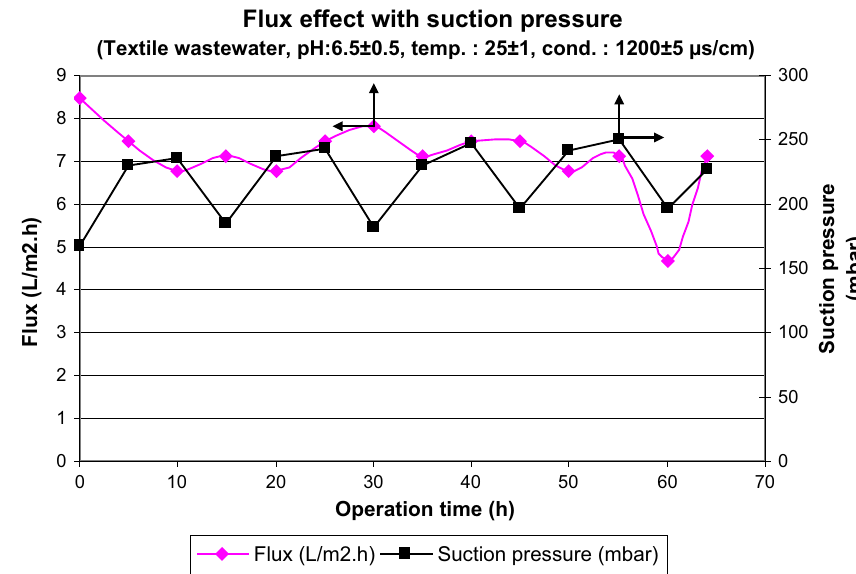
Fig. 3 Process parameters of pilot